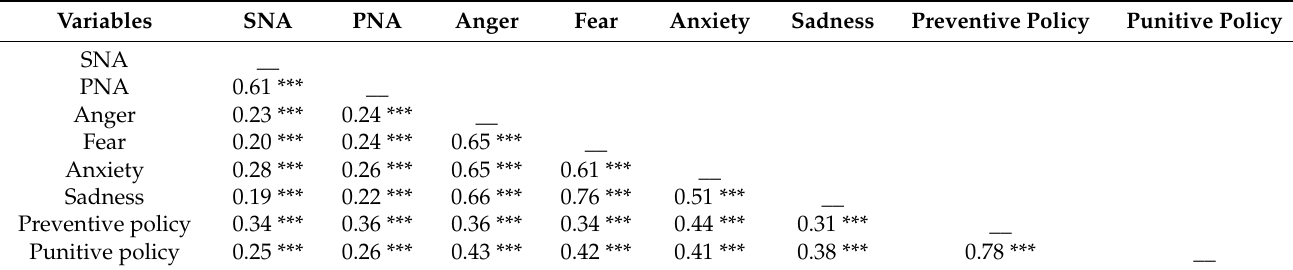
Table 1. Correlation between